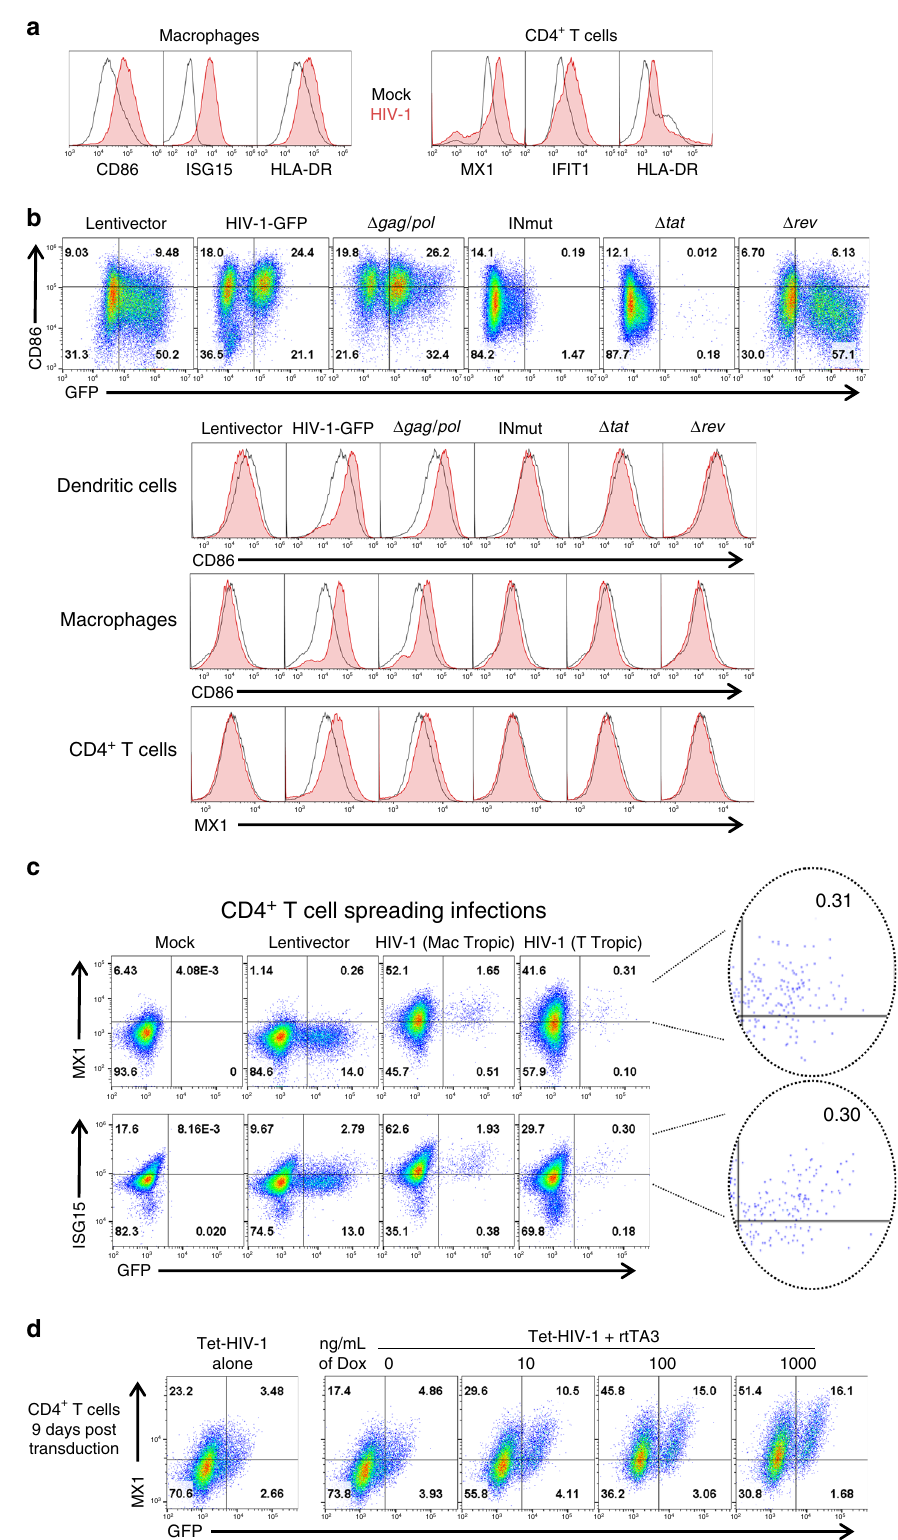
were cultured for 9 days with fresh media added at day 5. After 9 days, doxycycline was added at the indicated concentrations and assayed 3 days later. Non-HIV-1 challenge viruses . Sendai Virus Cantell Strain was purchased from Charles River Laboratories. Infections were performed with 200 HA units/mL on DCs for 3 days before assay by fl ow cytometry.